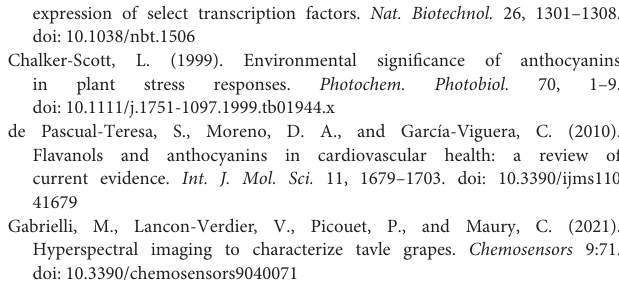
Supplementary Figure 1 | Reflectance index model for estimation of anthocyanin accumulation between the destructive (UV) and non-destructive (Hyperspectral), mARI of R706.35 (A) , mARI of R701.06 (B) , abs (C) , ARI (D) , and CI (E)